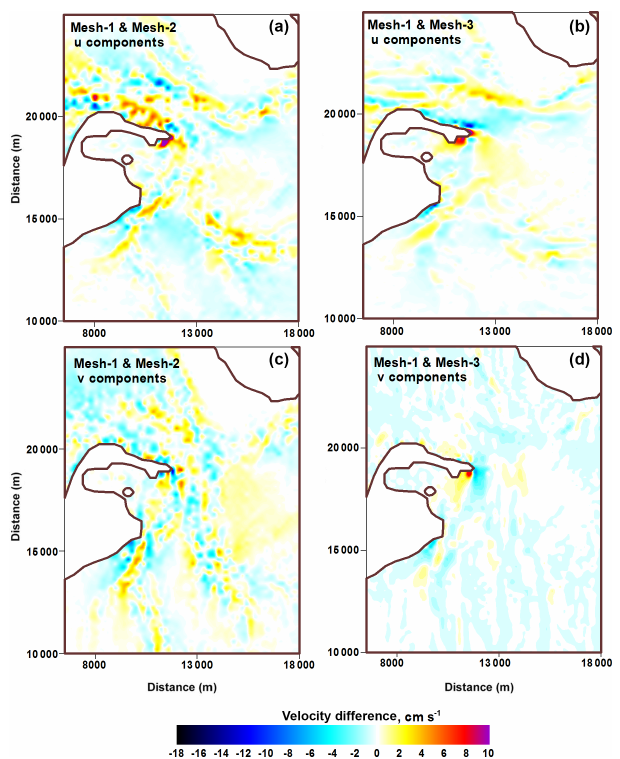
Figure 9. Spatial distribution of the difference between the hori- zontal velocities for the full tidal period of an M 2 wave: u compo- nent (a, b) ; v component (c, d) . The differences are between MESH- 1 and MESH-2 (a, c) and MESH-1 and MESH-3 (b, d) .